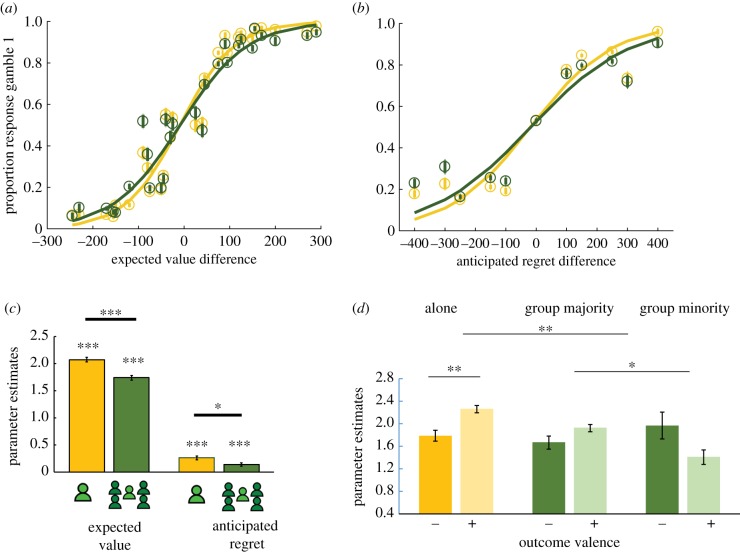
Lottery choice. (a) Proportion of choosing lottery 1 versus lottery 2 based on the difference in expected value ΔEV in experiment 2. (b) Proportion of choosing lottery 1 versus lottery 2 based on the difference in anticipated regret ΔAR in experiment 2. (a,b) Yellow represents the alone condition while green represents the group condition. Error bars represent standard errors of proportions. (c) Parameter estimates of expected value (ΔEV) and anticipated regret (ΔAR) in mixed models separately for trials where participants played alone (yellow) or in a group (green). (d) Parameter estimates of expected value (ΔEV) in mixed models separately following trials where participants experienced negative (−) and positive (+) outcomes on the previous round. From left to right: outcomes experienced alone (yellow), outcomes experienced in group majority (green), outcomes experienced in group minority (green) (c,d). Error bars represent the standard error of the estimated parameters in the mixed model. *p < 0.05, **p < 0.01, ***p < 0.001. (Online version in colour.)